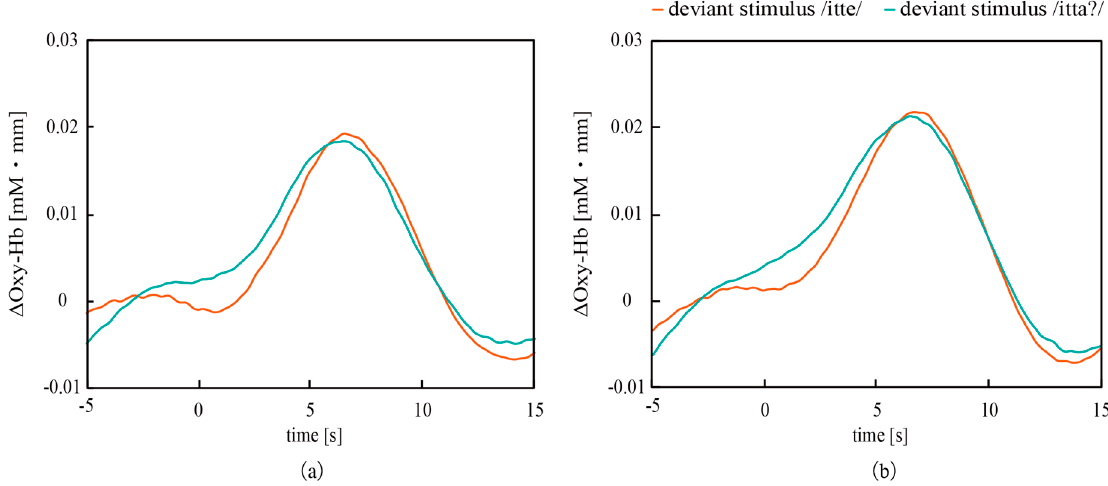
Figure 12. Variation in the concentrations of Oxy-Hb after the deviant stimuli, which were observed in the (a) left and (b) right auditory areas. Note that EEG has superior temporal resolution to NIRS. Table 2. The peak of the concentrations, MMN, and P300 in grand mean waves.